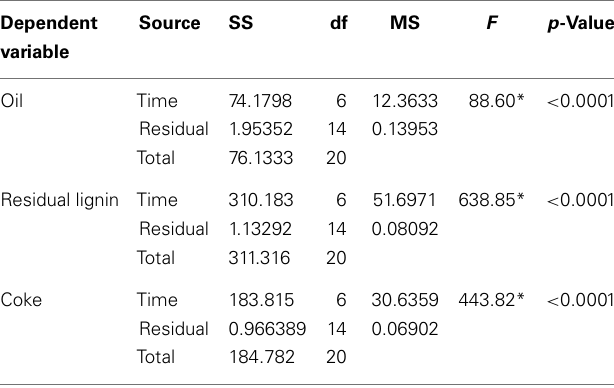
Table 1 | Summary of the one-wayANOVA analysis for the oil, residual lignin, and coke yields with reaction time as